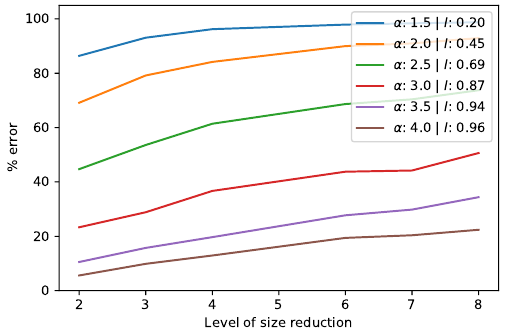
Figure 9. Error in the SVD of the product of two coarsened fields for various α ’s